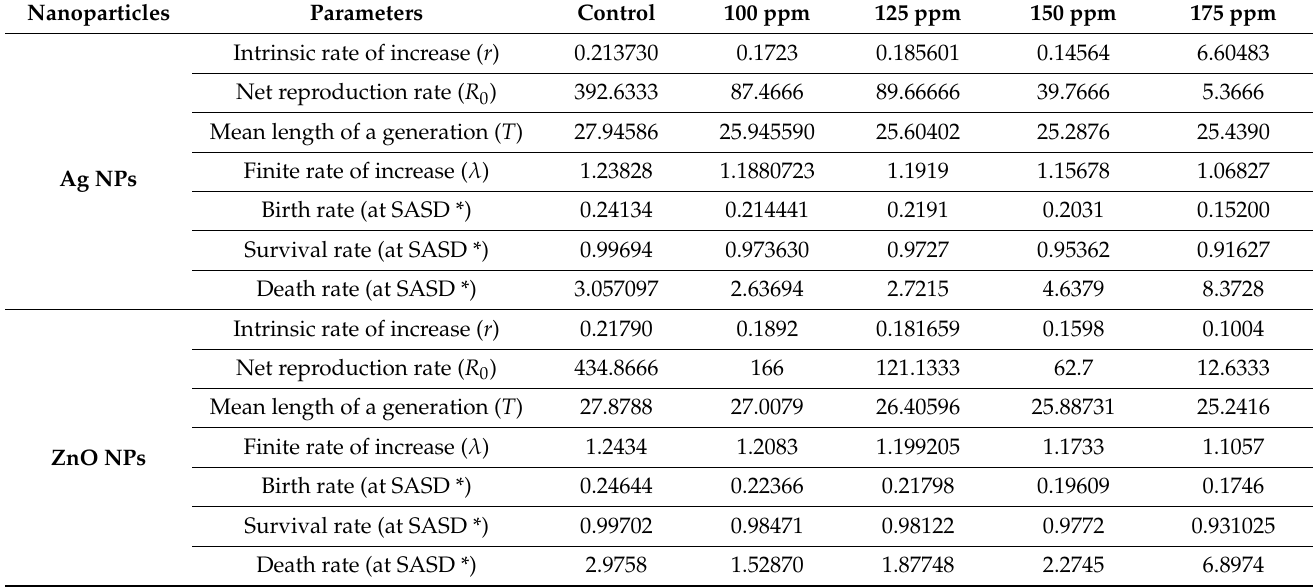
Table 4. Effects of Ag and ZnO NPs on demographic parameters of H. armigera